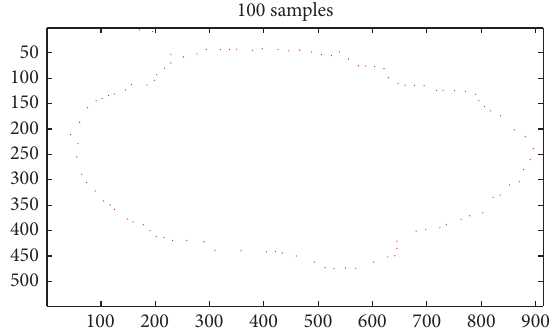
Figure 6: Detection result of Figure 5 by